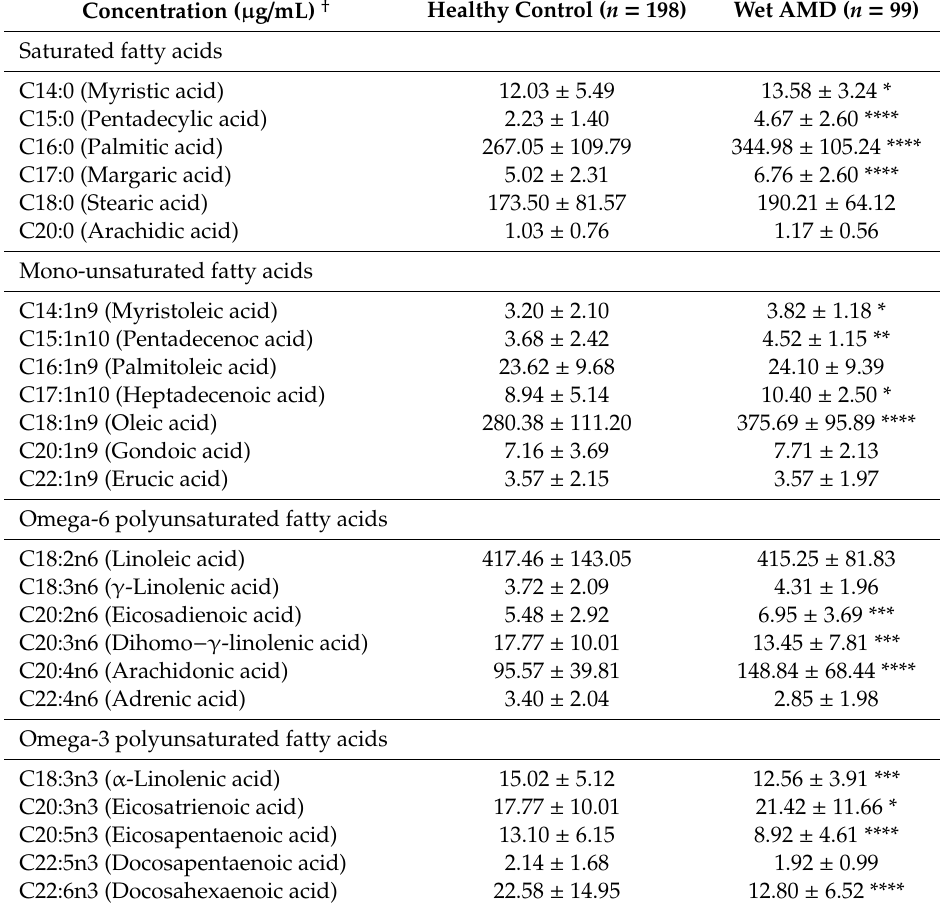
AMD, age-related macular degeneration. † Values are expressed as mean ± SD. * p < 0.05, ** p < 0.01, *** p <